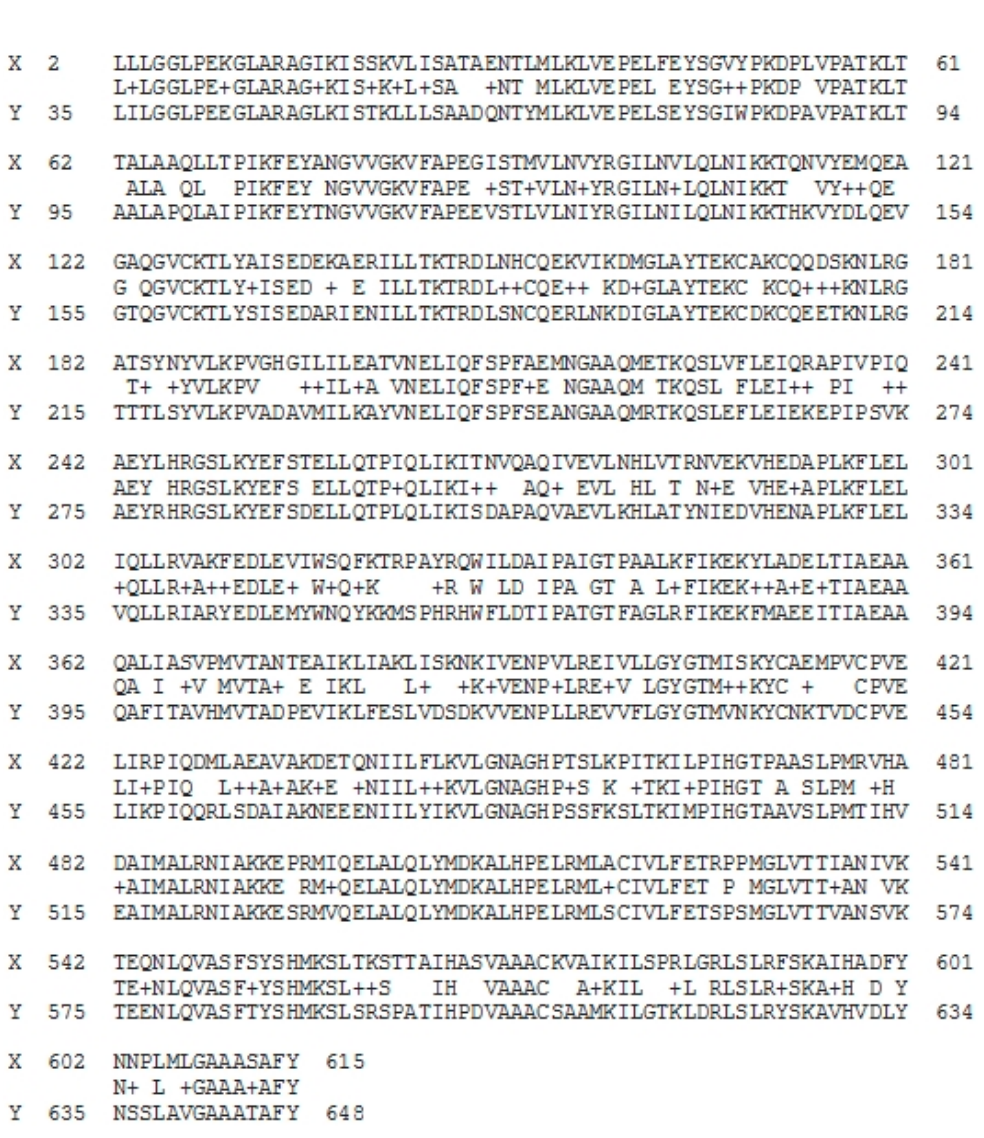
Figure 3. Blast analysis of aligned vitellogenin sequences from Epinephelus coioides (NCBI accession number: AAW29031.1; line X) and Epinephelus lanceolatus (obtained from Om et al. (2013); line Y) (accessed on 12 March 2018).